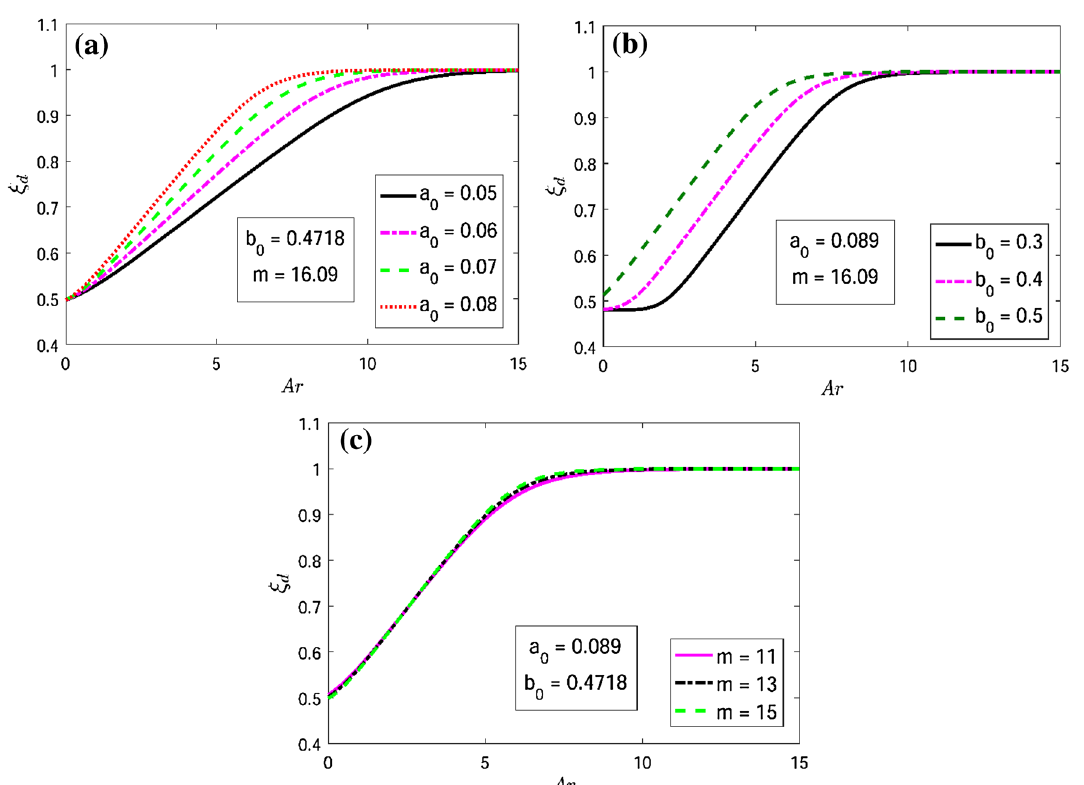
Fig. 3 Variation of model with